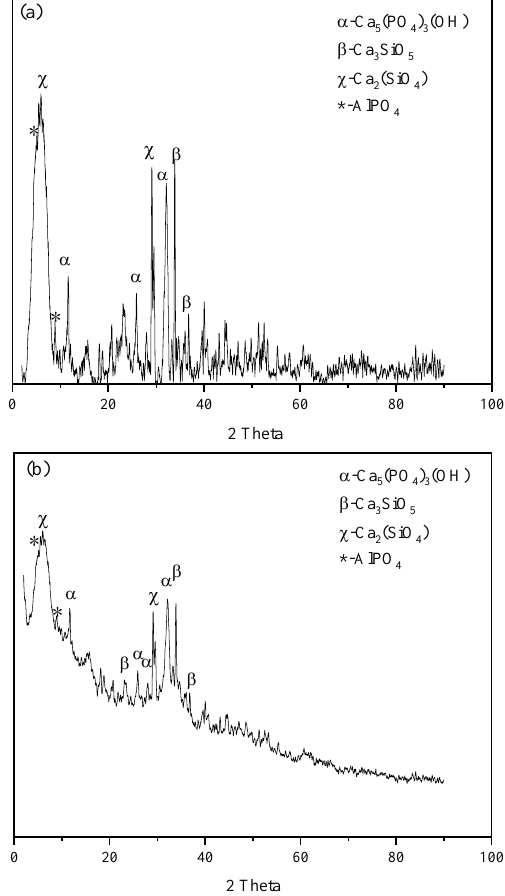
Figure 6. XRD of two kinds of precipitates in catholyte (( a ), precipitate 1, ( b ), precipitate 2). (Reference codes of Ca 5 (PO 4 ) 3 (OH), Ca 3 SiO 5 , Ca 2 (SiO 4 ) and AlPO 4 were 01-086-0740, 00-016-0406, 01-087-1258, and 01-088-1680, respectively.).